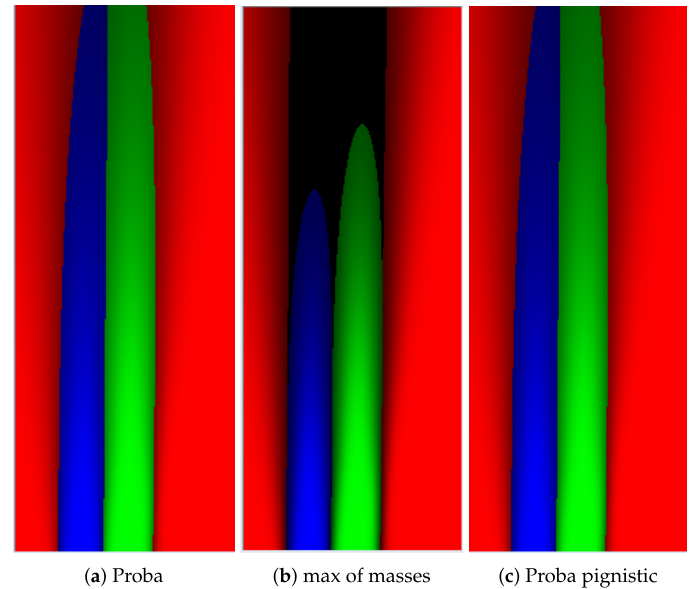
Figure 16. Decision grids used for path planning for